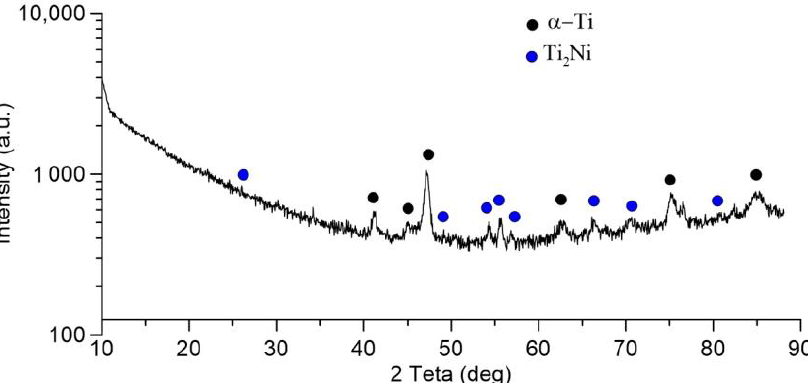
Figure 19. X-ray diffraction analysis of the fracture surface of the titanium alloy joint surface destroyed after mechanical testing.